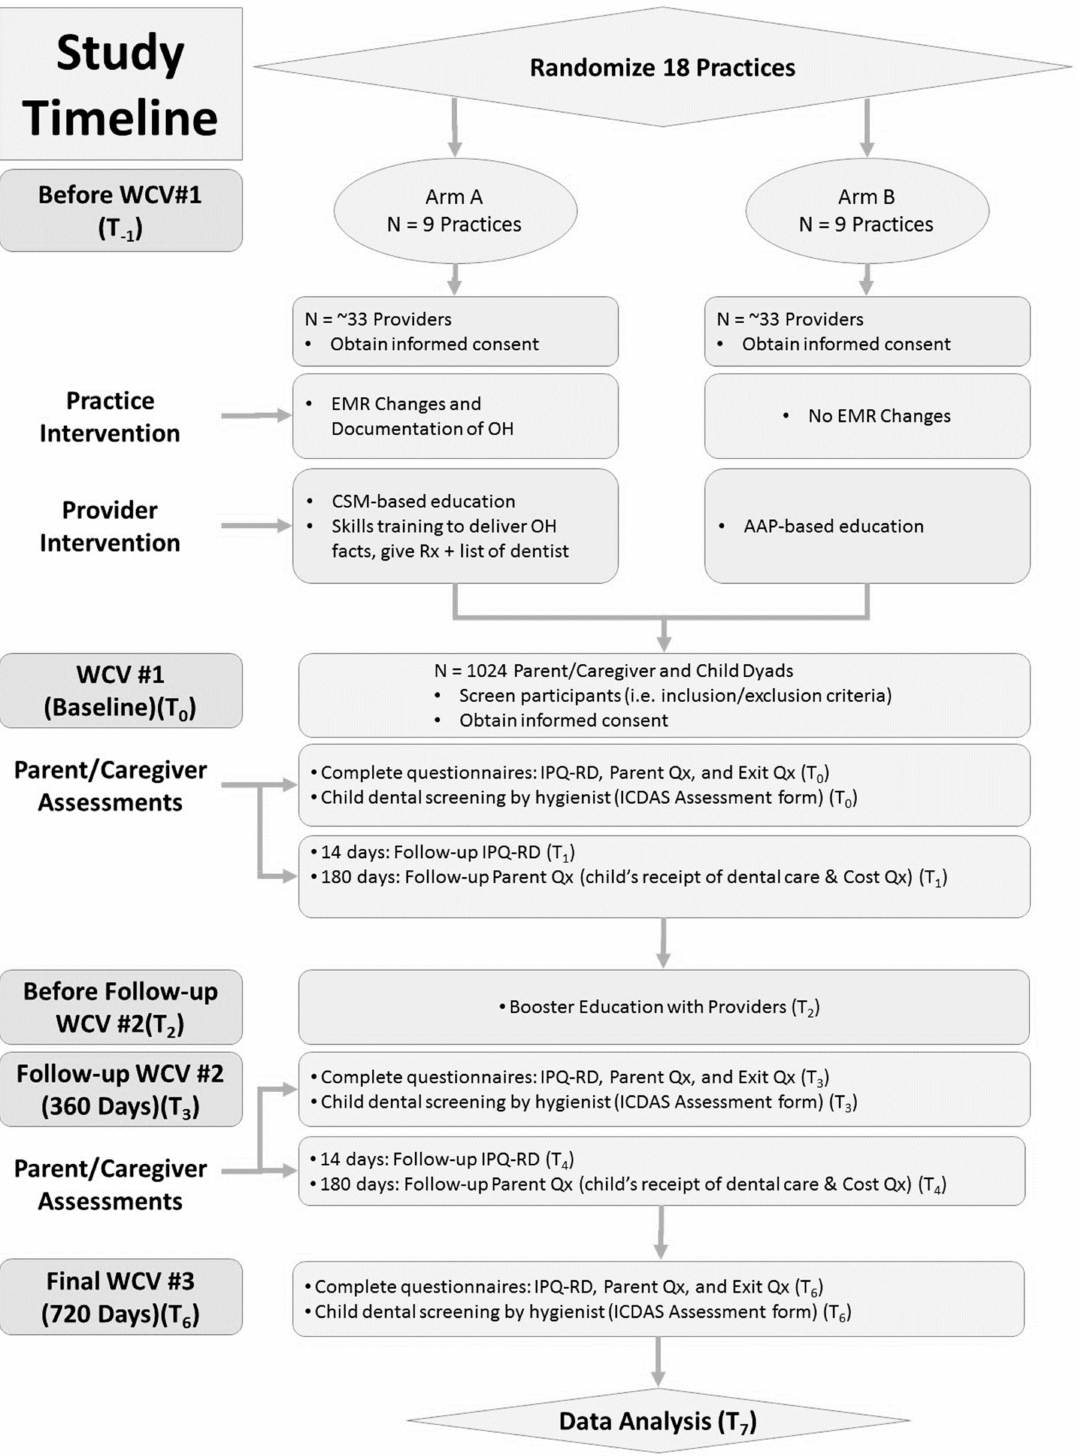
Figure 1. Study design of the main